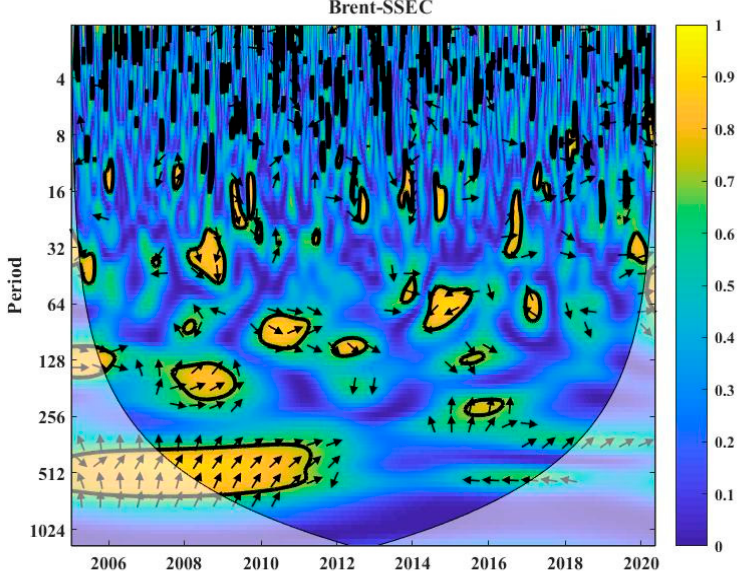
Figure 7. Wavelet coherent frequency spectra of Brent spot price and the Shanghai Composite Index.